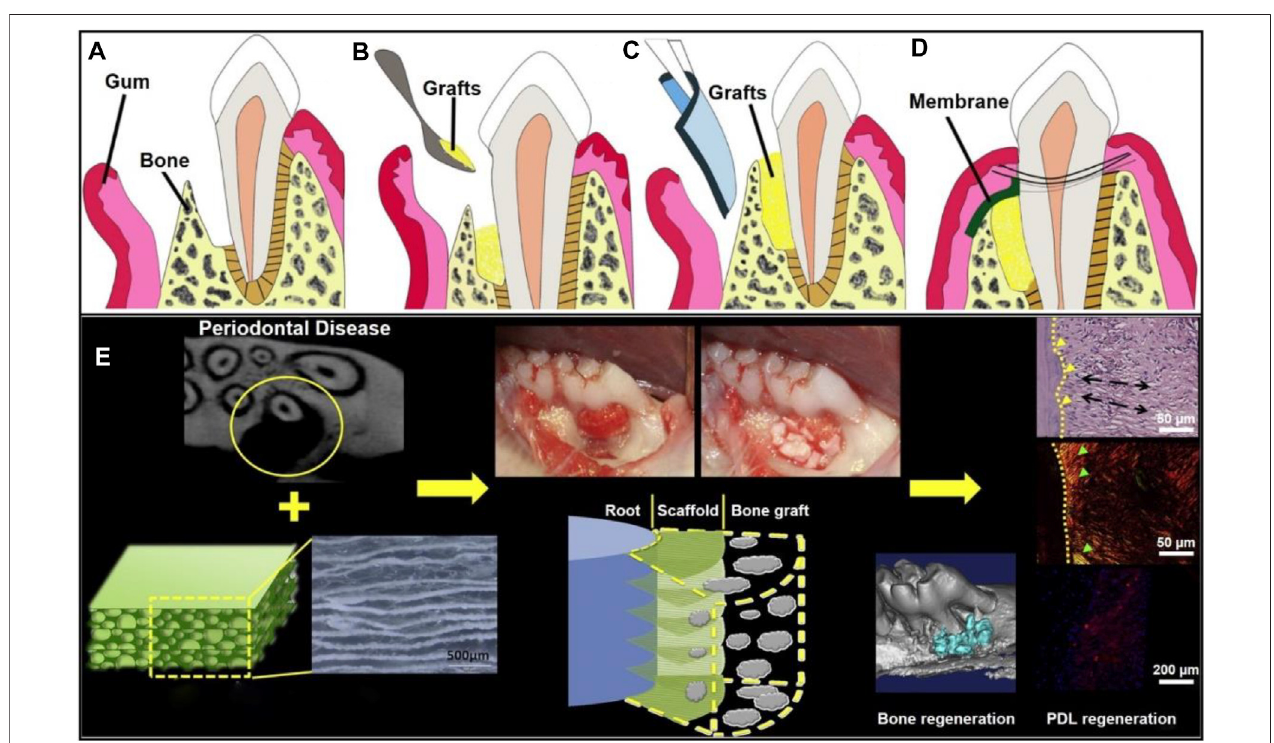
FIGURE 8 | Schematic illustration ofa GTR membrane combined with bone graft therapy for periodontal regeneration. (A) Periodontal defect with loss ofPDL and alveolar bone. Reproduced with permission (Chen et al., 2010). Copyright 2010, Elsevier. (B) Bone grafts at the defected site. Reproduced with permission (Chen et al., 2010).Copyright2010, Elsevier. (C) GTR/GBRmembranecovered onthegrafts.Reproduced withpermission(Chenet al.,2010).Copyright2010,Elsevier. (D) Sewing forwoundclosure.Reproducedwithpermission(Chenetal.,2010).Copyright2010,Elsevier. (E) OrganizedPDLregenerationwiththeuseofacompositescaffold made of PCL-PEG nano fi bers and chitosan. Reproduced with permission (Jiang et al., 2015). Copyright 2015, Elsevier.